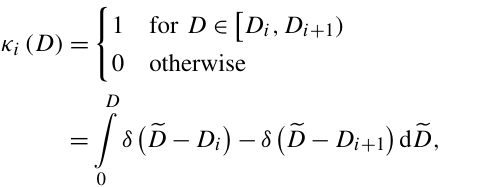
equivalent) diameter bin threshold values.